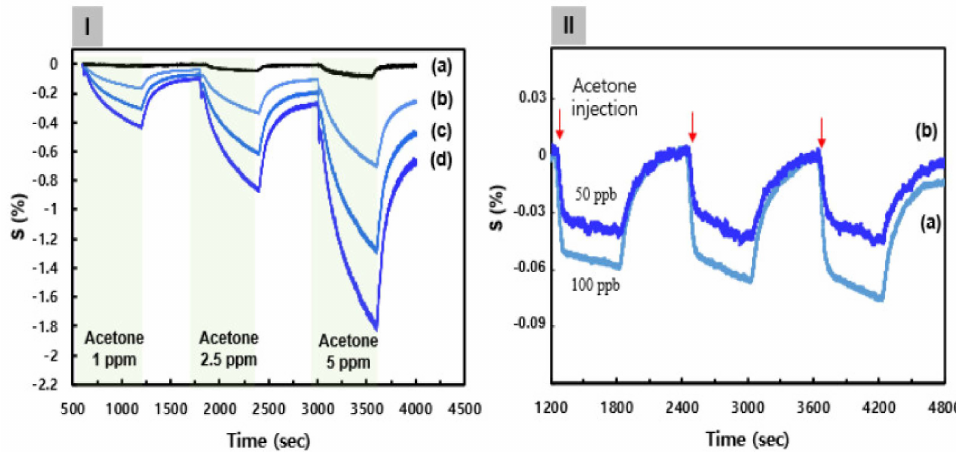
Figure 4. ( I ) The continuous dynamic response of the C8F-doped-PPy/PLA@SWCNT sensor to